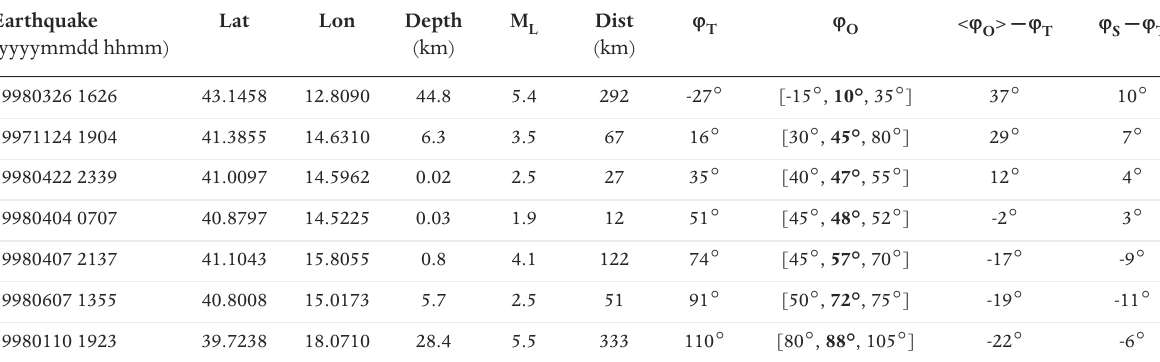
Table 1. Source location and some other parameters of the 7 earthquakes discussed in this paper. Hypocenter and magnitude were taken from the catalog, while distance and theoretical backazimuth were computed from epicenter and array site coordinates. Earthquakes are or- . The observed backazimuth { was estimated by array analysis by considering the first 3 dered with increasing theoretical backazimuth { T O s of signals (average values are indicated in bold inside the range of observed values). The last two columns contain the difference range be- tween observed backazimuth and theoretical backazimuth, and between synthetic backazimuth and theoretical beckazimuth,